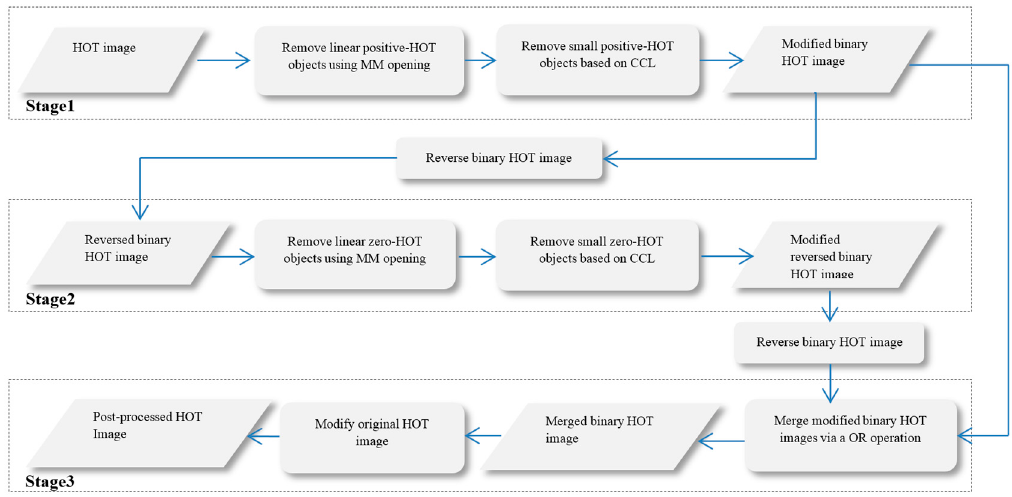
Figure 3. Flowchart of HOT image post-processing. The three stages are for removing small-scale clear-high-HOT and haze-zero-HOT spurious HOT responses from a HOT image and modifying the original HOT image according to the results from the first two stages, respectively. MM and CCL stand for mathematical morphology and connected component labeling, respectively.